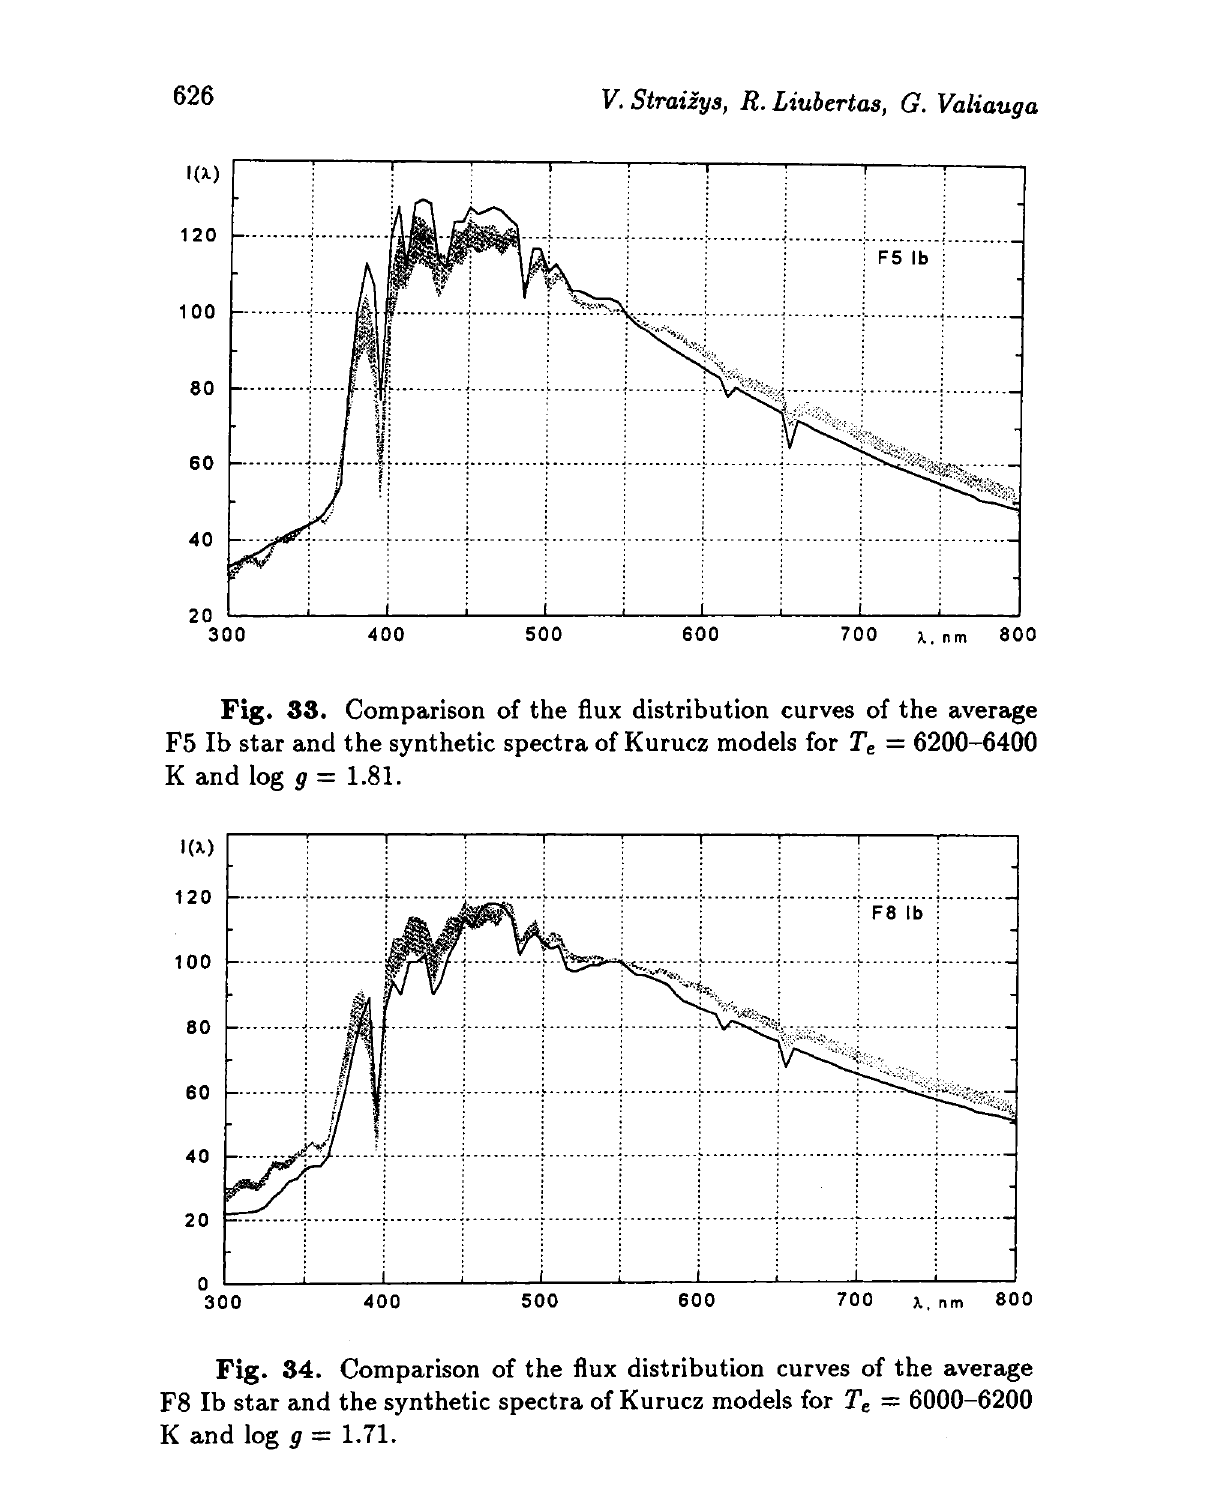
Fig. 34. Comparison of the flux distribution curves of the average F8 lb star and the synthetic spectra of Kurucz models for T e = 6000-6200 K and log g =